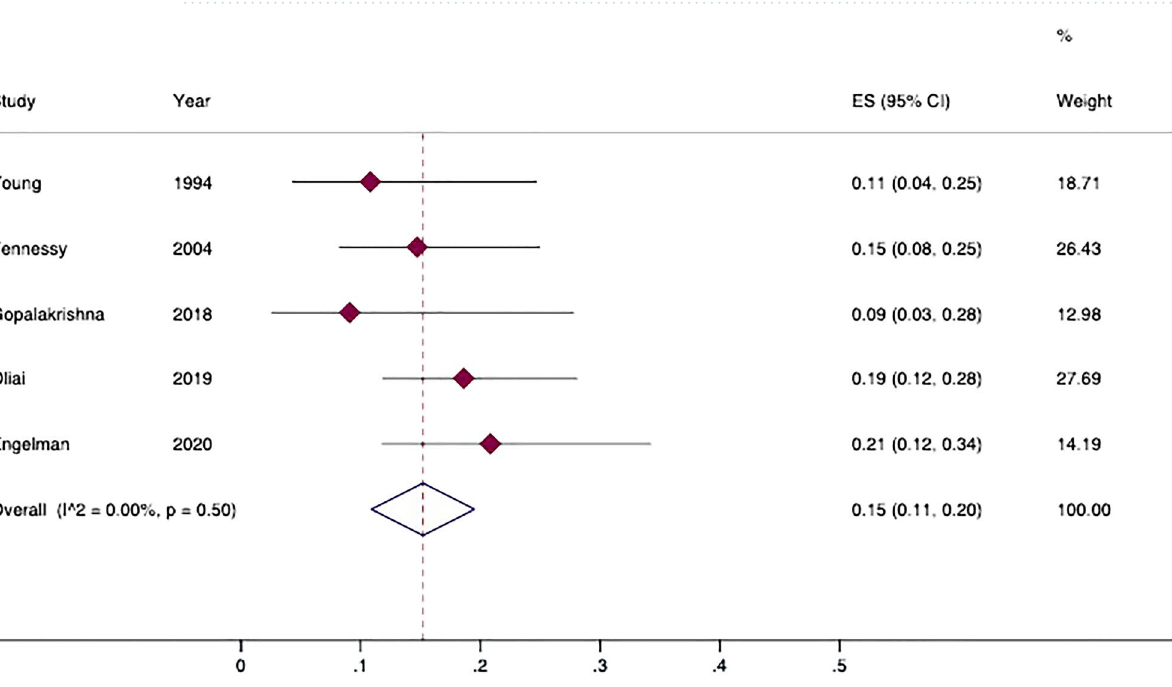
studies reported survival outcomes. The overall survival and time from the first detection of liver metastasis to pseudocirrhosis was reported in only by one study (69 months and 18 months respectively; N = 37 patients) 1 . Similarly, data on the median time from pseudocirrhosis to death was reported by 2 studies (3.6 and 8.5 months, respectively) 12,24 .